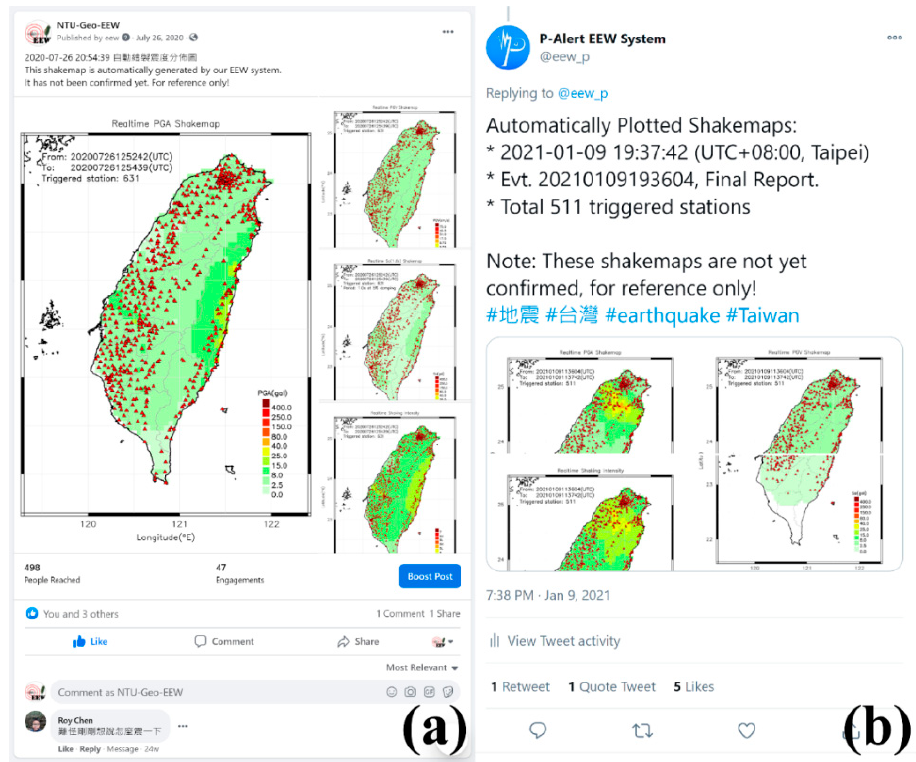
Figure 4. The information posted on social media like Facebook (a) and Twitter (b) within seconds after the earthquake occurrence.